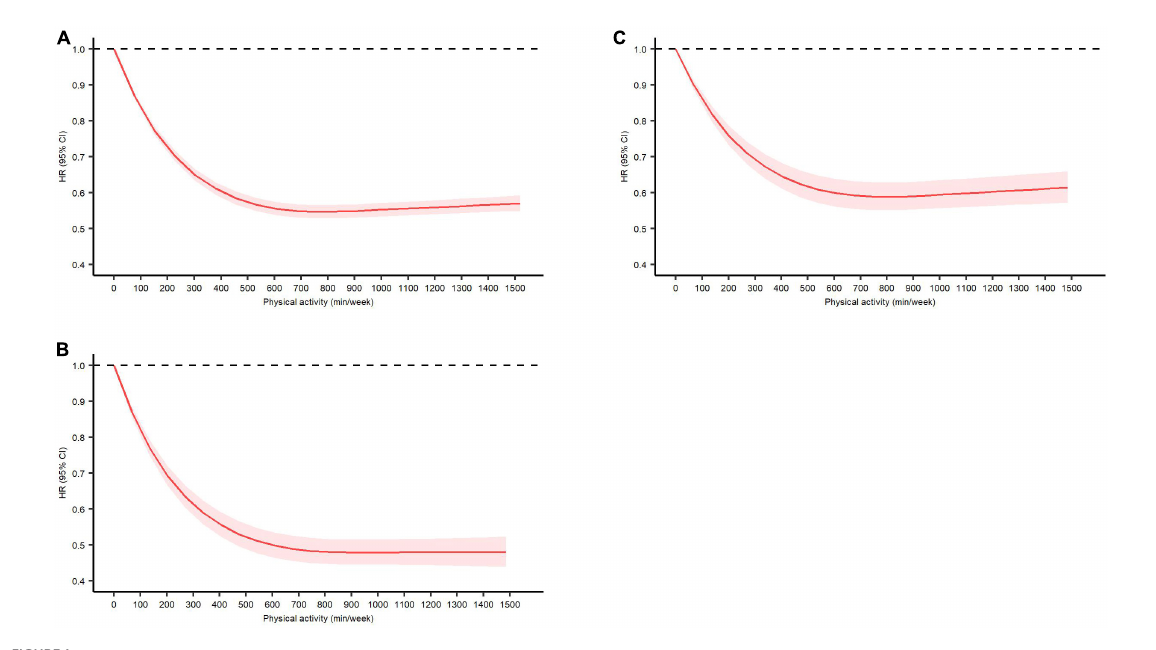
FIGURE1 Dose-response relationship between total leisure-time physical activity (minutes/week) and (A) all-cause mortality, (B) cardiovascular disease-specific mortality, and (C) cancer-specific mortality in adults with major chronic diseases with adjustment for age, sex, and race/ethnicity, education level, marital status, body mass index, smoking status, drinking status, the number of chronic diseases, and muscle-strengthening activity. Data are presented as hazard ratio and 95% confidence